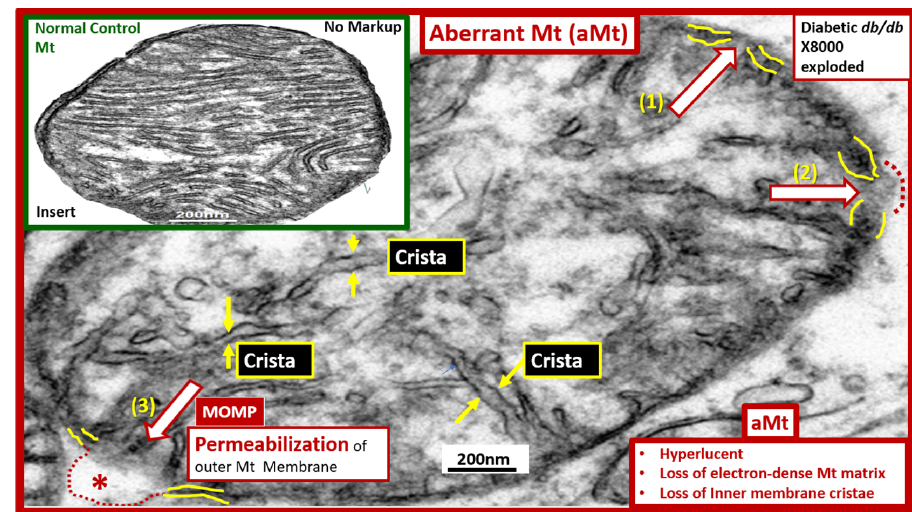
Figure 2. Aberrant mitochondria (aMt). This image depicts an exploded aberrant mitochondrion with an intact scale bar from a 20-week-old obese, insulin-resistant, diabetic db/db female mouse model. aMt are a common phenotype found in multiple different cells and organs in models of obesity, insulin resistance, metabolic syndrome, and type 2 diabetes mellitus as compared to control healthy C57BL/6J models (insert upper left from Figure 1A). The mitochondria organelles, along with the nucleus are known to be contained by outer and inner membrane structures similar to the cellular plasma membrane (fine yellow lines of the mitochondrion outer and inner membranes). This aberrant mitochondrion depicts the ultrastructural remodeling that is found to be present in almost all of the subsequent TEM images. aMt may be characterized by their hyperlucency, loss of cristae (yellow arrows), loss of electron-dense mitochondrial matrix, and loss or disruption of the outer membranes (red open arrows). aMt are known to be leaky with disruption or loss of the Mt outer membranes as depicted in (1) thinning of the inner and outer membranes (open red arrow); (2) interruption of the inner and outer membranes with partial permeabilization (open red arrow and red dashed line); (3) complete loss of the inner and outer membranes with permeabilization of the outer membrane (open red arrow, dashed red lines, and asterisk). Importantly, the mitochondrial outer membrane permeabilization (MOMP) allows the contents of the Mt to leak damaging superoxide—mitochondria reactive oxygen species (mtROS), which are capable of reacting with nitrogen, and sulfur species from the iron-sulfur complexes known to be present in complex I and the cytosol to form a reactive species interactome (RSI) consisting of reactive oxygen, nitrogen, sulfur species (RONSS), and the apoptotic death-promoting protein cytochrome c. Additionally, MOMP allows the leakage of mtDNA that can activate damage-associated molecular patterns (DAMPs) that are capable of initiating a sterile inflammatory response by binding to pattern-recognition receptors. Importantly, MOMP is considered to be a ‘point of no return’ as this event is responsible for engaging the apoptotic cascade in numerous cell death pathways. The development of MOMP is thought to be associated with the pro-apoptotic BCL-2-associated X protein (BAX) or B-cell lymphoma-2 (BCL-2) antagonist or killer (BAK). However, it is important to also note that an increase in nutrient excess and resultant mtROS may damage the outer membrane lipoproteins via mtROS induced lipid peroxidation, propagation of lipid peroxidation chain reactions, and increase the opportunity for MOMP to occur from the “inside- out” to damage the outer Mt membrane. Additionally, the emerging role of activated mitochondrial matrix metalloproteinases (mtMMPs) may also play a role in outer membrane permeabilization. This aberrant phenotype results in a loss of function of the electron transport chain responsible for the production of cellular energy—adenosine triphosphate (ATP). Importantly, if there is an impairment in mitophagy, leaky aMt via mitochondria permeability transition pores (MPTPs) and MOMPs will accumulate in cells and contribute to ongoing cellular dysfunction and damage due to ATP depletion and eventually cellular apoptosis via cytochrome c. Original magnification × 8000; with intact scale bar = 200 nm. TEM = transmission electron